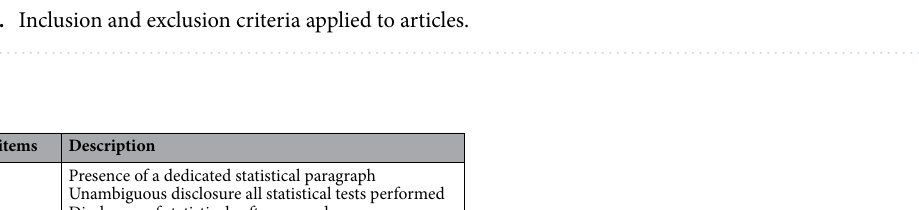
Inclusion criteria Exclusion criteria Table 3. Inclusion and exclusion criteria applied to articles.